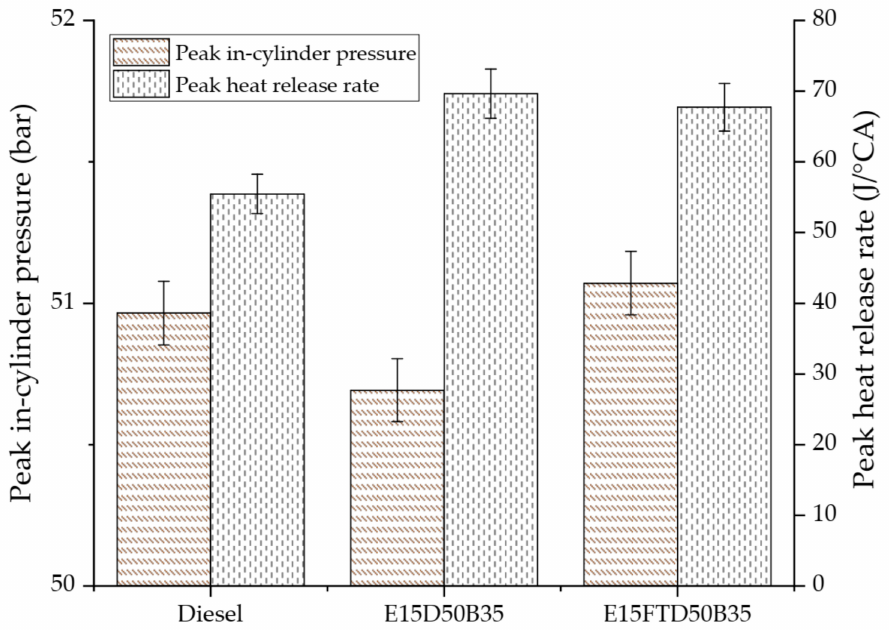
Figure 4. Peak in-cylinder pressure and peak heat release for diesel, E15D50B35, and E15FTD50B35 at 2 bar IMEP and 1500